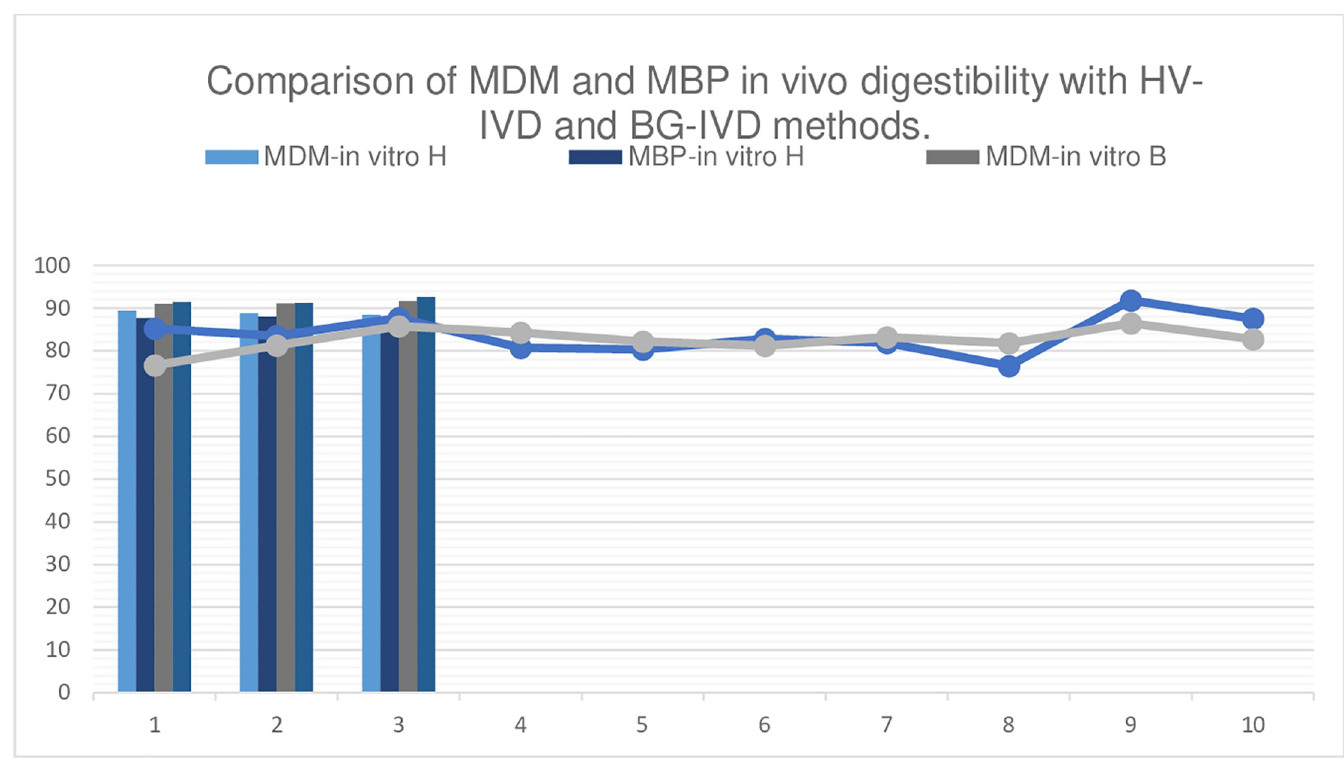
Fig 3. Comparison of MDM and MBP in vivo digestibility with HV-IVD and BG-IVD methods.